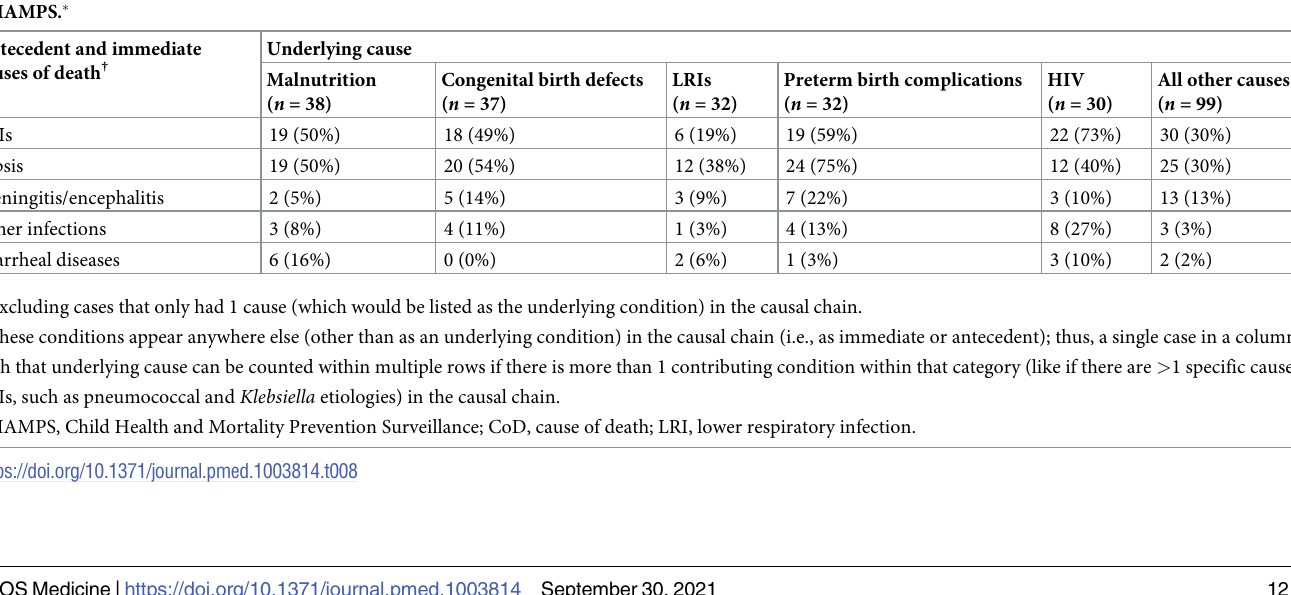
LRI, lower respiratory infection.